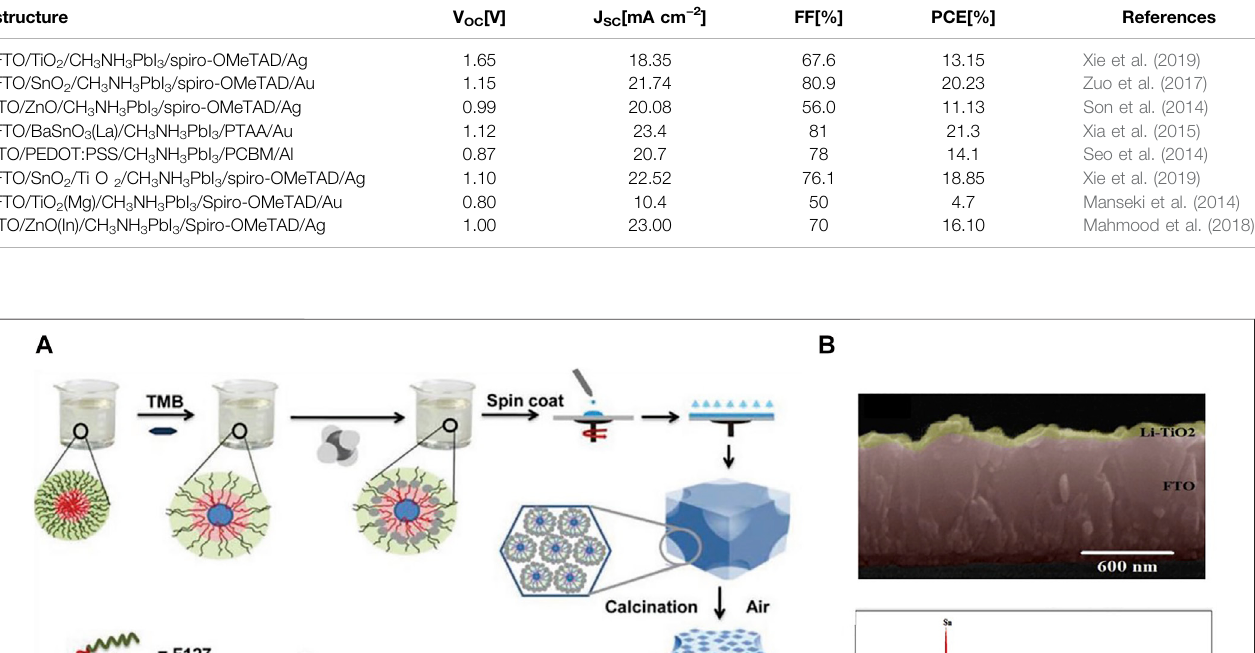
TABLE 2 | Perovskite solar cells with different structures corresponding to performance parameters of devices. structure